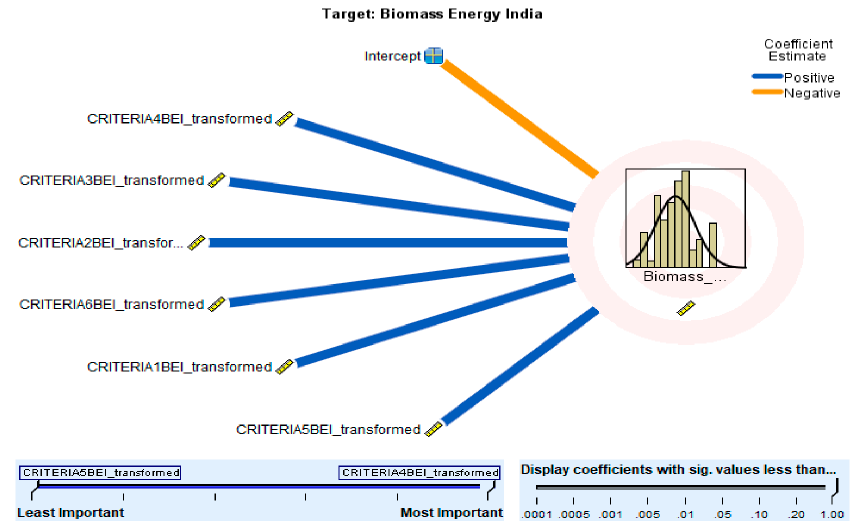
Figure 15. BE India GCV Criteria. Source: ALM Analysis SPSS by Author.